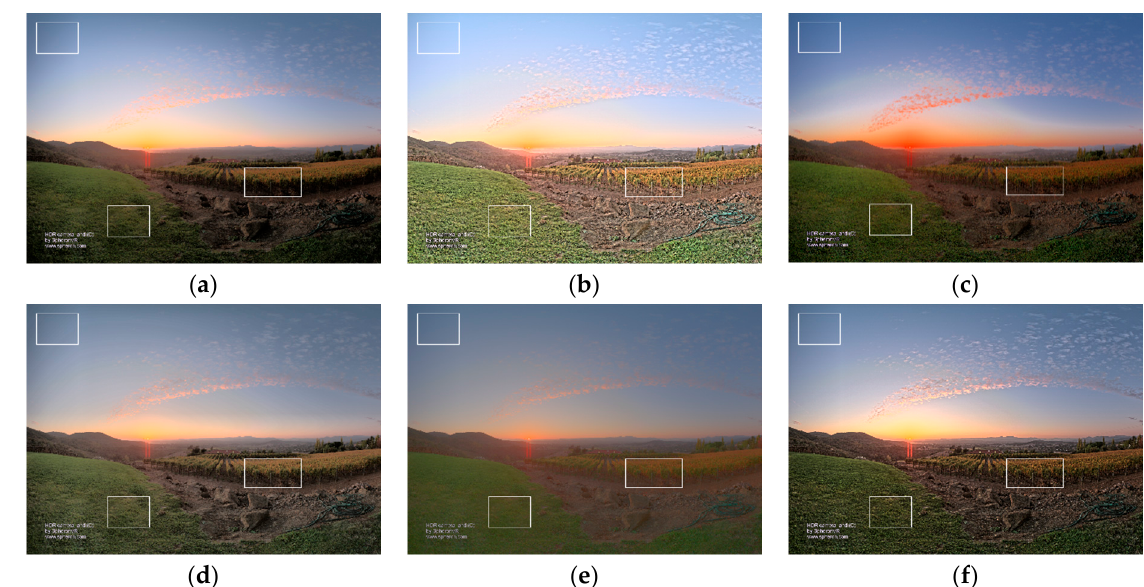
Figure 8. Results of the test image Spheron_NapaValley by ( a ) Khan et al. [9], ( b ) Gu et al. [11], ( c ) Gao et al. [28], ( d ) Ok et al. [23], ( e ) Yang et al. [21], and ( f ) the proposed method. The white rectangles indicate the areas which should be closely examined by the reader.